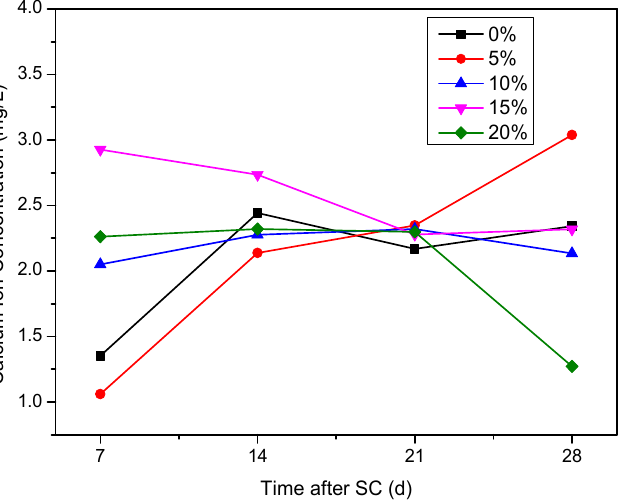
Figure 16. Ca 2+ concentration in the cathode side solution of the specimens with different silica fume content.